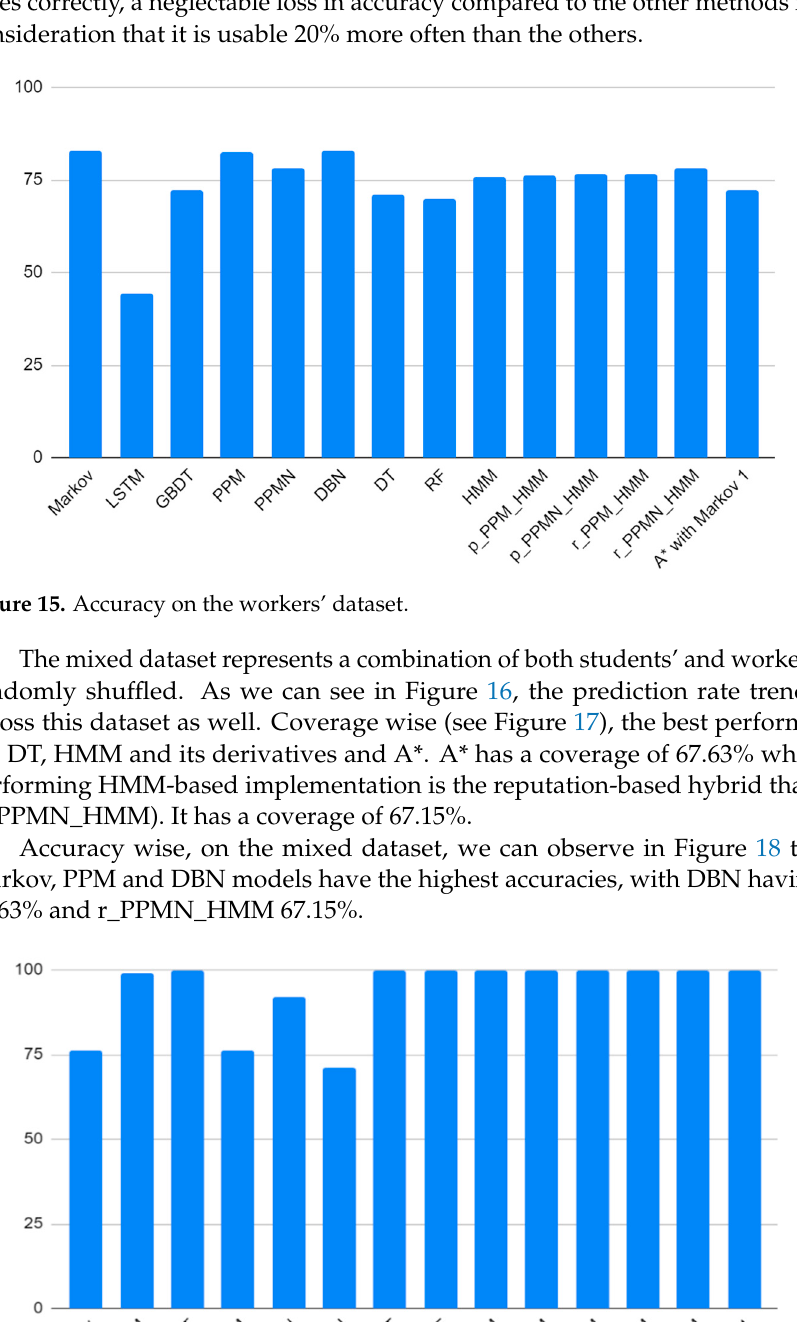
Figure 16. Prediction rate on the mixed dataset.